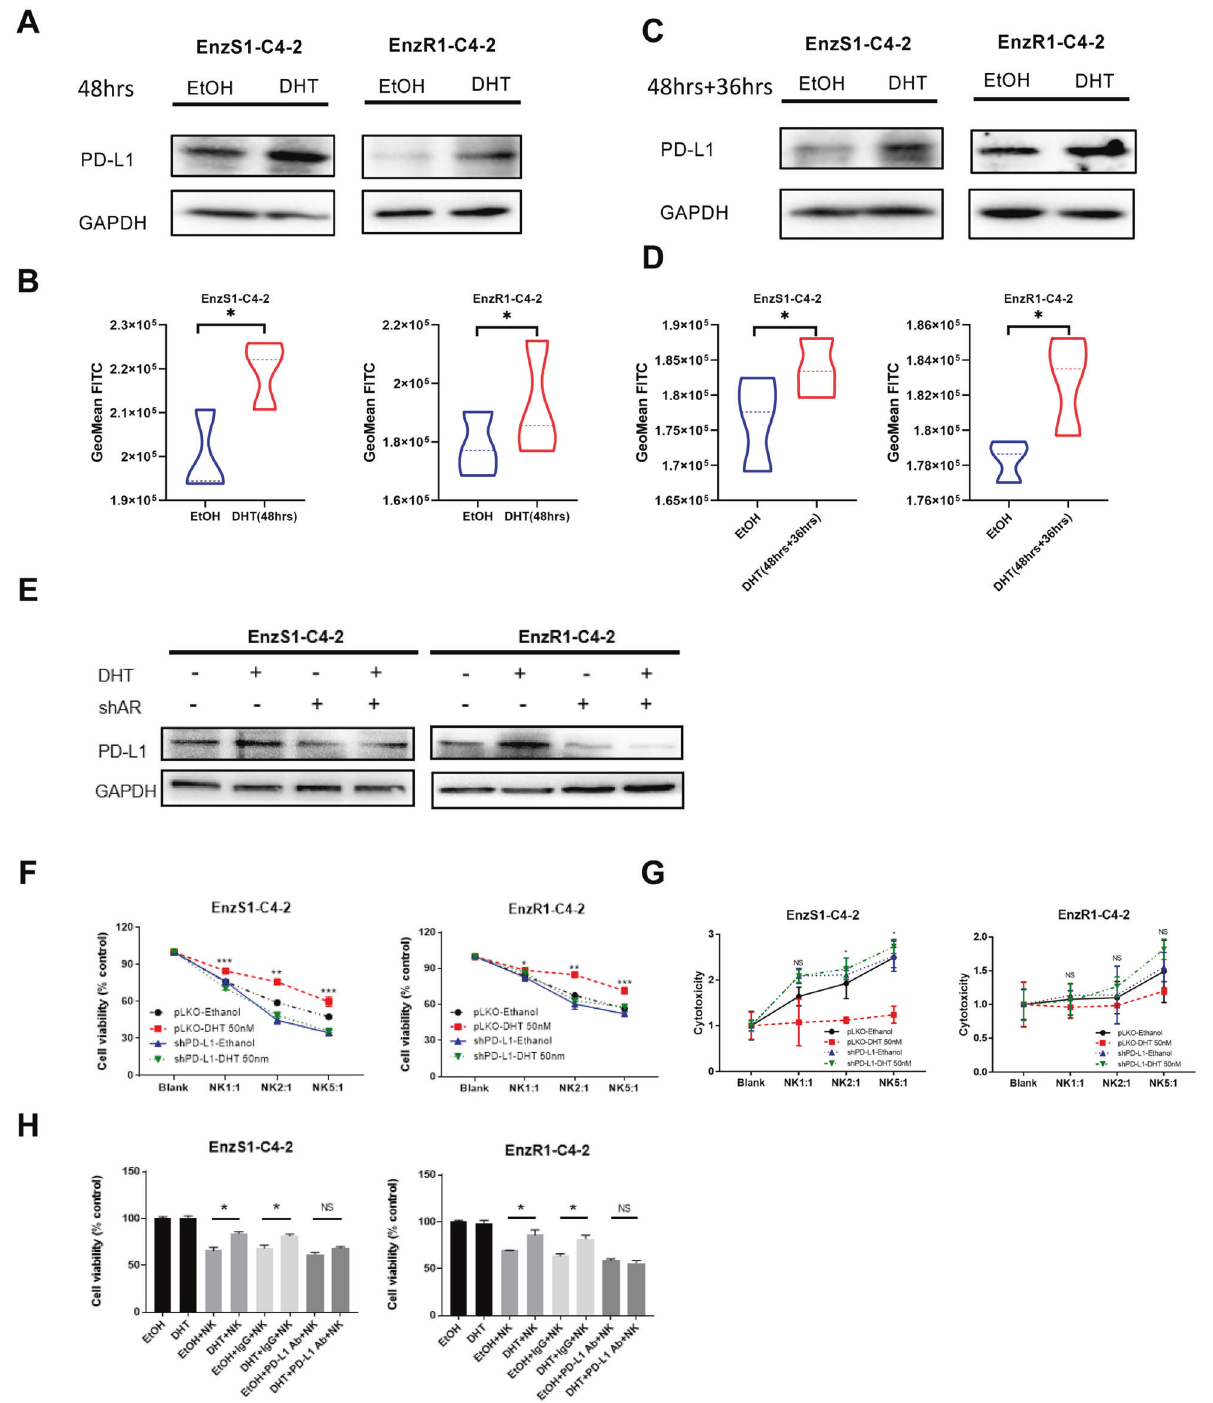
Fig. 2 A high dose DHT/AR suppresses NK cells immunotherapy ef fi cacy towards CRPC cells via up-regulating PD-L1 expression in CRPC cells. A , B After treating EnzS1-C4-2 (left panel) and EnzR1-C4-2 (right panel) cell lines with 50 nM DHT for 48 h, the protein was extracted to run western blot ( A ) to test PD-L1 protein expression and Flow cytometry ( B ) showed the change in surface expression of PD-L1. GeoMean FITC standed for relative expression of PD-L1 C , D After treated with 50 nM DHT for 48 h, the CRPC cells were allowed to grow in fresh media for another 36 h. Then total PD-L1 protein was measured with western blot ( C ) and surface PD-L1 protein was detected with fl ow cytometry ( D ). E Full length AR was inhibited in EnzS1-C4-2 (left panel) and EnzR1-C4-2 (right panel) cells, cells were treated with 50 nM DHT for 48 h, then western blot was performed to test PD-L1 changes compared with scr group. F , G Before treating EnzS1-C4-2 and EnzR1-C4-2 cells with 50 nM DHT, PD-L1 expression was knocked down. After treatment, MTT ( F ) and LDH assay G were performed separately using NK92-MI cells to target CRPC cells. H After treating EnzS1-C4-2 and EnzR1-C4-2 cells with 50 nM DHT for 48 h, PD-L1 neutralizing antibody or IgG control antibody, as well as NK92-MI cells, were added for 36 h, then MTT assay was performed to evaluate the NK cell cytotoxicity. * p < 0.05, ** p < 0.01, *** p < 0.001, NS Not Signi fi cant.